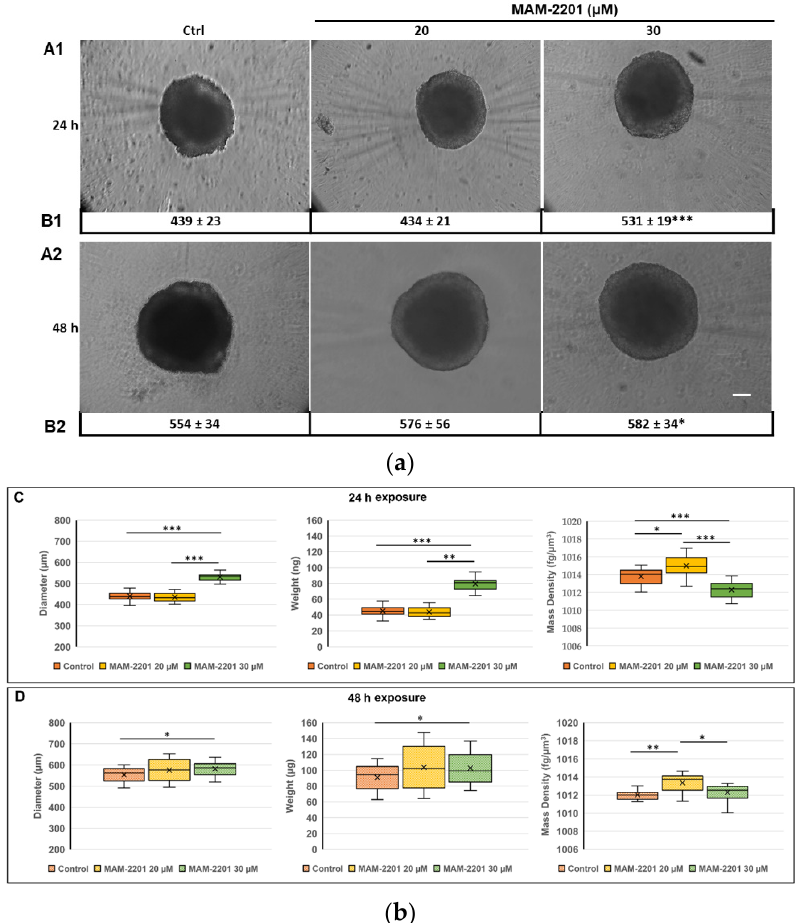
Figure 2. ( a ) Morphology analysis by phase-contrast microscopy of the D384 spheroids after MAM- 2201 exposure: MAM-2201 treatments did not cause morphological alterations to the spheroidal structure of spheroids, but induced an increase in the spheroid size at the highest concentration tested (30 µ M) for both the 24 h ( A1 , B1 ) and 48 h ( A2 , B2 ) time points considered. Scale bar: 100 µ m. ( b ) Biophysical characterization of D384 spheroids after 24 h ( C ) and 48 h ( D ) of MAM-2201 exposure in terms of (left panels) size, (central panels) weight, and (right panels) mass density. Box-and-whisker plots are indicative of the population distribution. * p < 0.05, ** p < 0.01, *** p <